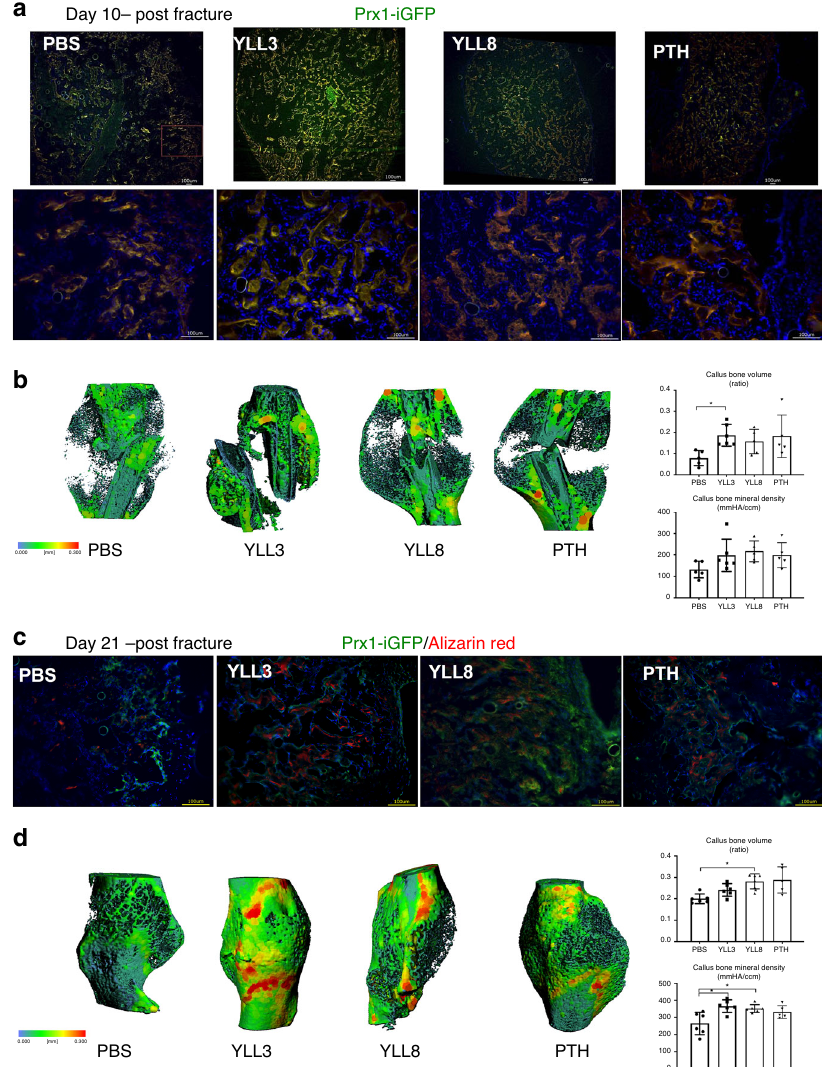
Fig. 6 YLL3 induced higher callus mineralization during fracture healing. Female Prx1 ERT -GFP mice were fractured at 2 months of age and received tamoxifen at 10 mg/kg for 3 days. YLL3 or YLL8 were given at 10 μ g/kg, and hPTH (1 – 34) was given at 40 μ g/kg, s.c., 5x/week for 10 or 21 days. a Representative callus images from the outer edge of the callus in indicated treatment groups at day 10 post fracture viewing under low power (4x) or high power (20x). Scale bar = 100 µ m. b Representative microCT thickness mapping of the callus, callus bone volume, and bone mineral content from indicated treatment groups at day 10 post fracture. Columns represented individual values in each group and the error bars represented standard deviations. N = 5 animals group. * p < 0.05 between the treated groups versus PBS-treated group using one-way ANOVA followed by Dunnett ’ s multiple comparison post hoc test. c Representative callus images from the outer edge of the callus in indicated treatment groups at 21 days post fracture. Alizarin red was given at − 1 day before euthanization. Scale bar = 100 µ m. d Representative microCT thickness mapping of the callus, callus bone volume, and bone mineral content from indicated treatment groups at day 21 post fracture. Columns represented individual values in each group and the error bars represented standard deviations. N = 6 animals/group in PBS, YLL3, and YLL8-treated group and n = 5 in PTH-treated group. * p < 0.05 between the treated groups versus PBS- treated group using one-way ANOVA followed by Dunnett ’ s multiple comparison post hoc